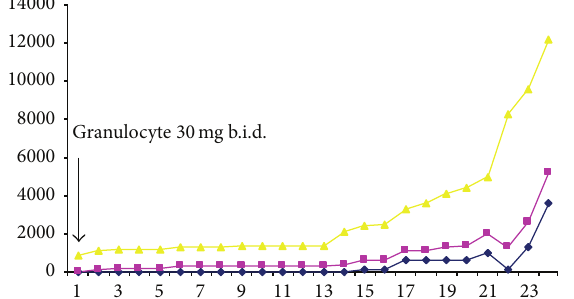
Figure 3: The course of the patient’s eosinophils (blue line), baso- philes (pink line), and monocytes (yellow line) white blood cell count during granulocyte treatment; b.i.d.: twice a